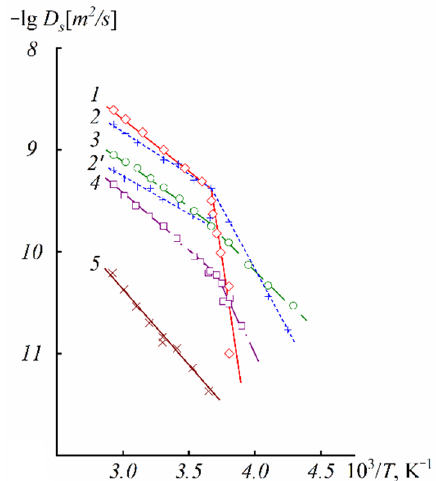
Figure 30. Temperature dependences of water self-diffusion coefficients at different water contents in the Ag + ionic form of CU-23: 1, λ = 13.9; 4, λ = 4.1; and in H + ionic form of the MC-44 membrane: 2,2’, λ = 15.1; 3, λ = 8.3; 5, λ = 1.4. Adapted from [33].